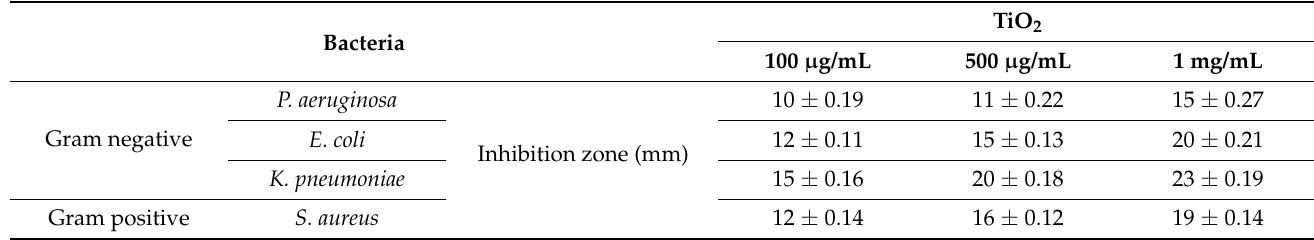
Table 1. The table summarizes the experimental parameters and detail of the bacteria.